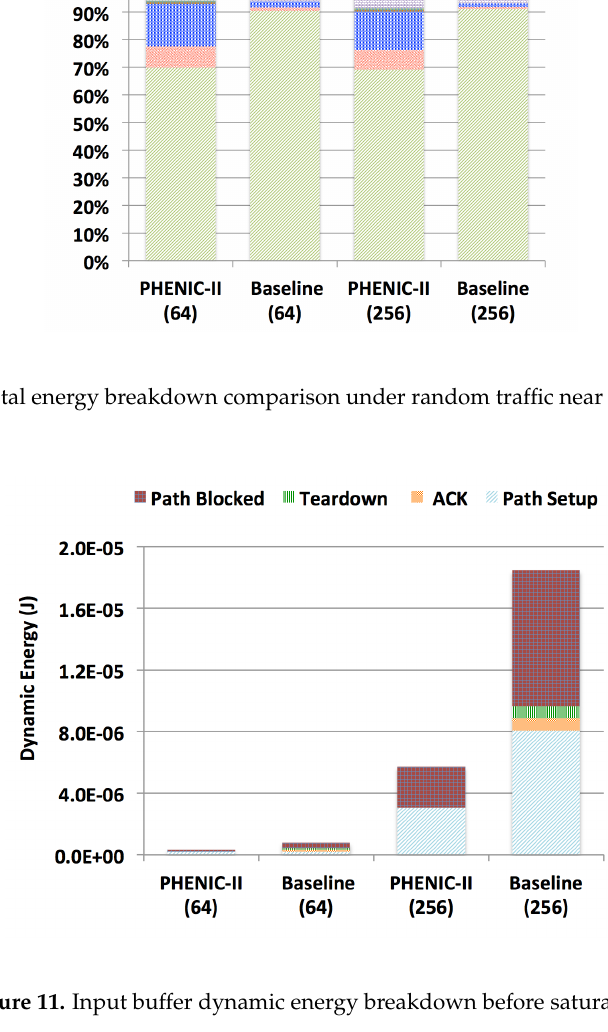
Figure 11. Input buffer dynamic energy breakdown before